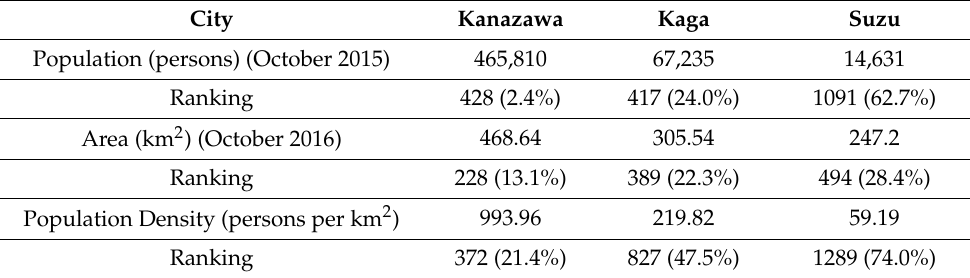
Table 1. Population, area, and population density of three target